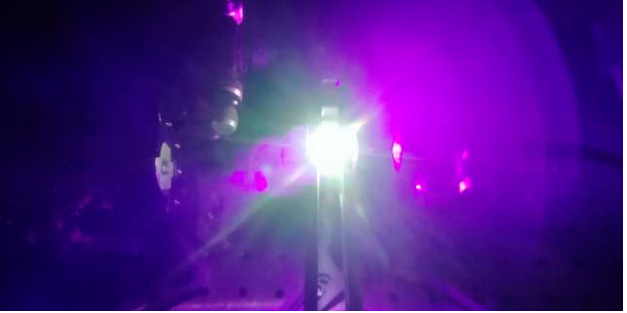
Figure 5. ( a ) Scheme of Yb 2+ -doped glass laser; ( b ) a simple glass solid laser cavity with Yb 2+ glass and ( c ) super-broadband fluorescence of Yb 2+ -doped glass in the F–P cavity using a 405 nm laser pump.